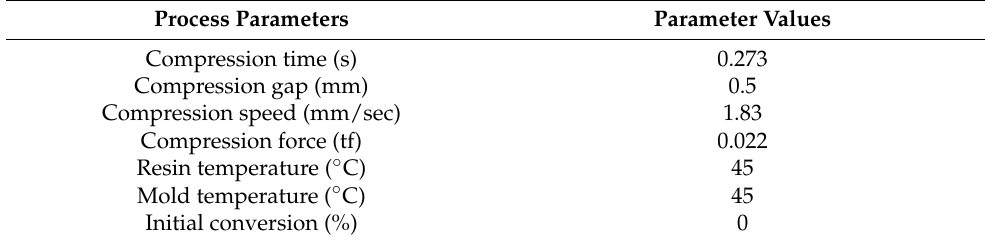
Table 5. The parameters of the dipping process in Cases 1 and